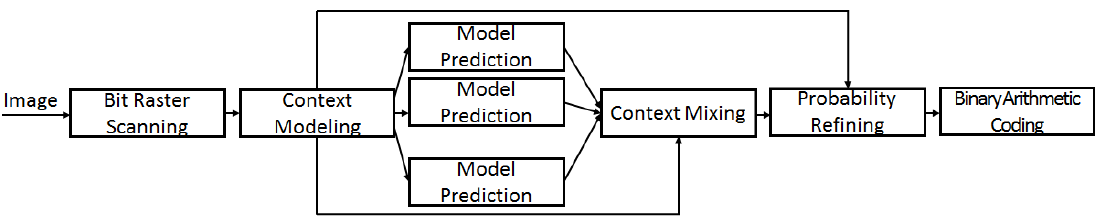
Figure 1. PAQ8 Image compression diagram.